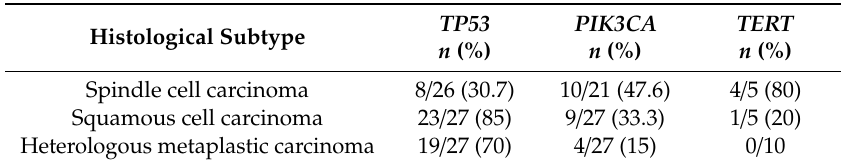
Table 3. Distribution of TP53, PIK3CA , and TERT mutations in three di ff erent histological subtypes (from references